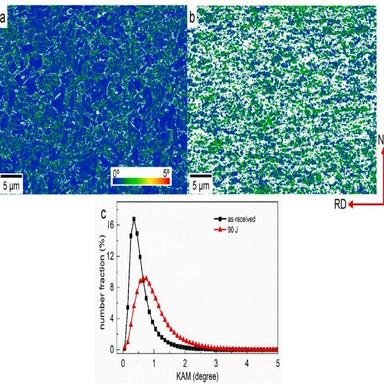
KAM maps of (a) as-received material and (b) sample impacted with 90 J energy. The white spots in (a) and (b) are non-indexed points. (c) Statistic distribution of KAM maps.